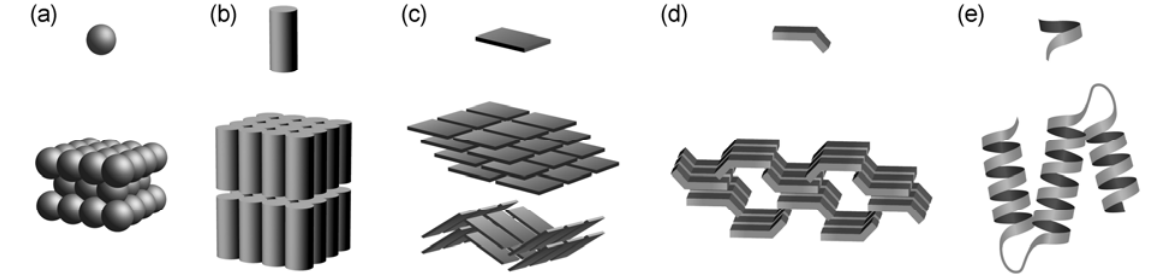
Figure 1. Relationship between molecular structures and crystal structures; (a) spherical, (b) axial, (c) flat, (d) arched, and (e) chain